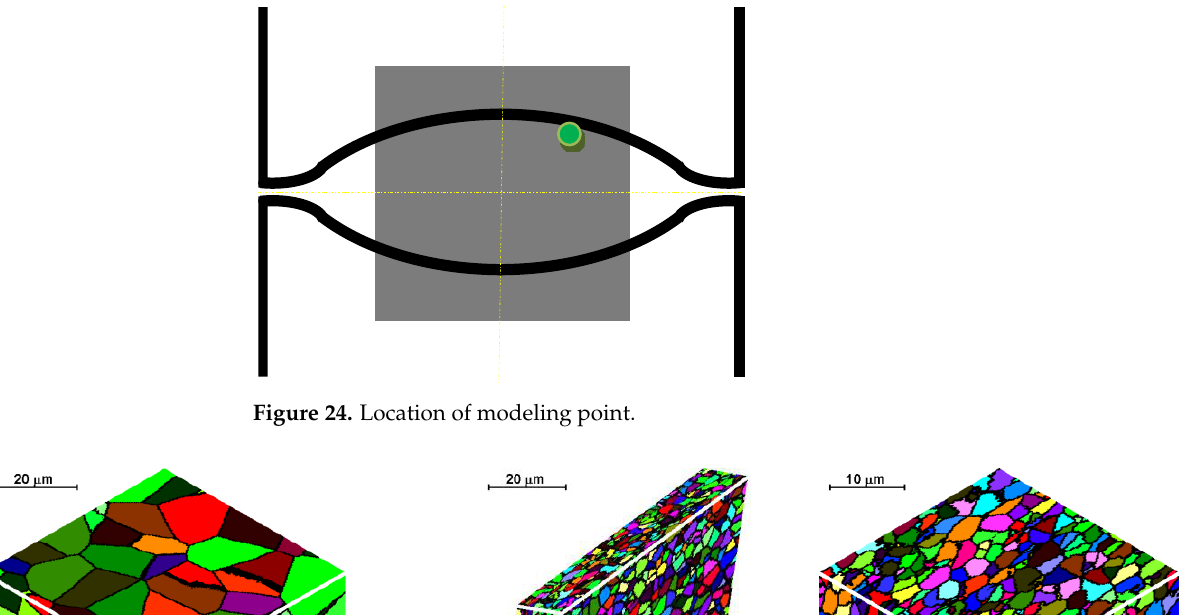
Figure 23. Modeling scheme of the shape rolling.